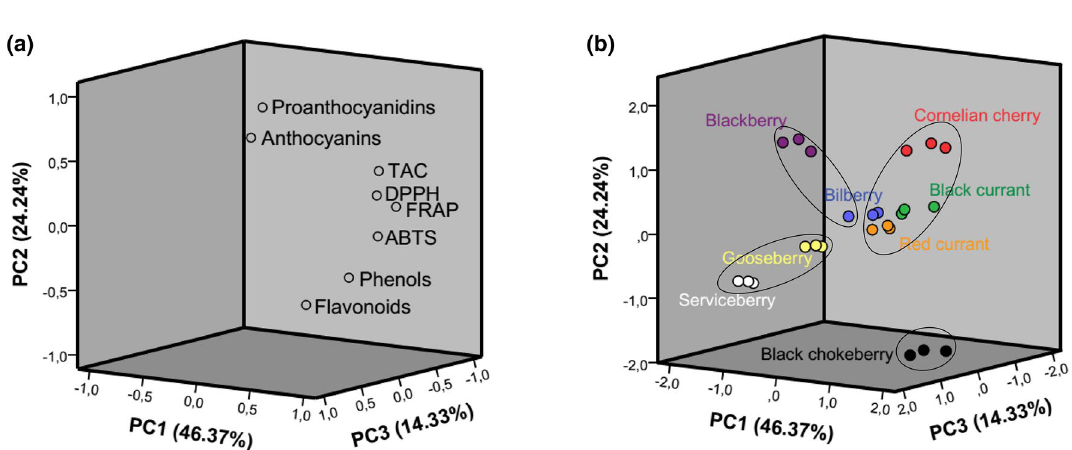
Figure 1. Classification of berries into tertiles by test results (in reverse order for DPPH EC 50 ). TP total phenolic compounds, TF total flavonoids, P proanthocyanidins, A anthocyanins; T1 first tertile, T2 second tertile.